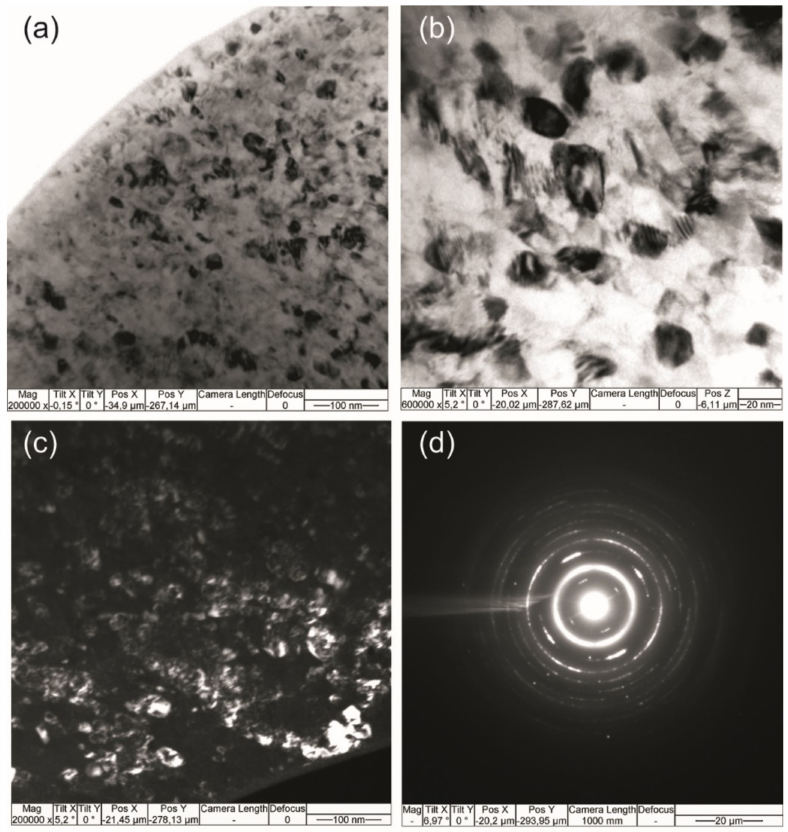
Figure 12. ( a – c ) TEM images of the nanocrystalline structure of 60 µ m NiTi wire and ( d ) the corre- sponding diffraction pattern from the B2